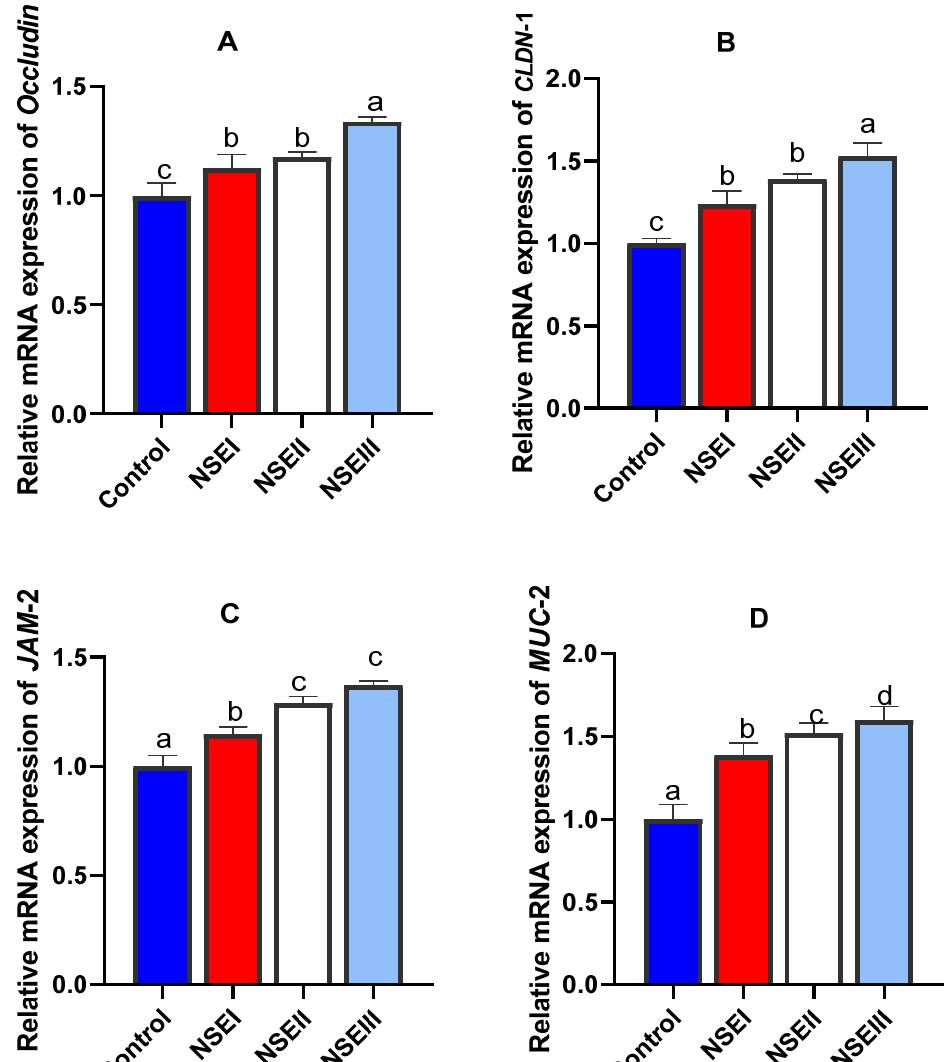
Figure 1. Gene expression of occludin ( A ), claudins-1 (CLDN-1, ( B )), junctional adhesion molecule-2 (JAM-2, ( C )) and mucin-2 (MUC-2, ( D )) quantified using qRT-PCR in the jejunal tissues of rabbits fed various levels of N. sativa oil extract (NSE) at 60 d of age. Values represent means with their SE in bars. Control: rabbits offered the basal diet, NSEI, NSEII and NSEIII: rabbits fed graded levels of NSE comprising 125, 250 and 500 mg/kg diets, respectively. a–d Means carrying different superscript letters indicate statistical significance ( p <